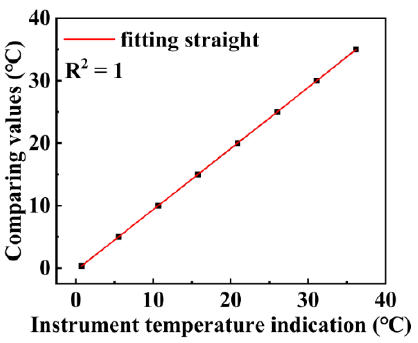
Figure 3. Results of the temperature sensor calibration experiment.